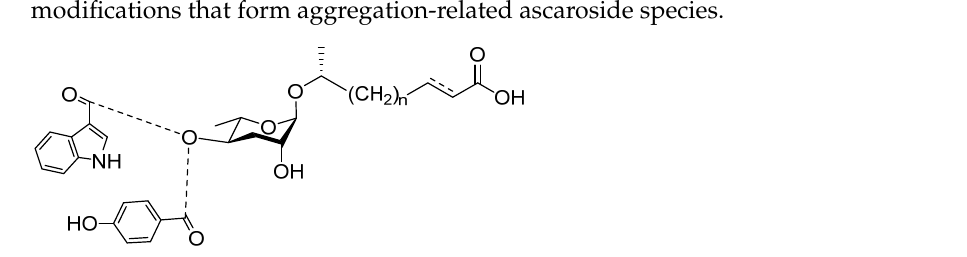
Figure 3. Overview of the chemical structure of the aggregation of pheromones secreted by nema- todes.